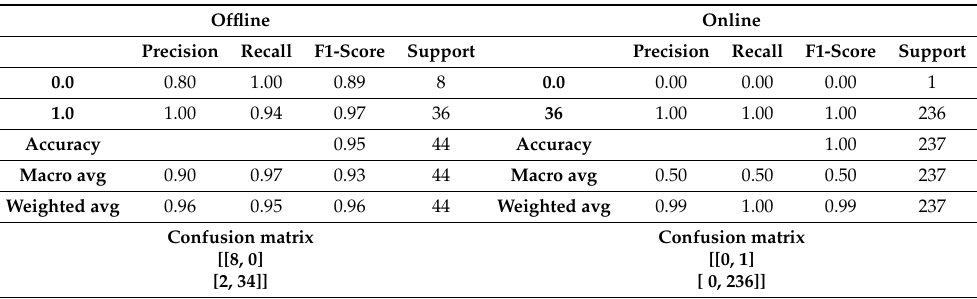
Table 6. RF classification